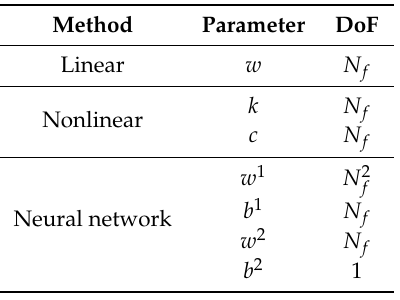
Table 1. Learnable parameters and their associated degrees of freedom (DoF) for the statistical models used in the present study. The degree of freedom is given for the prediction of a single arbitrary turbine within the wind farm with N f turbines in front. The linear and nonlinear learnable parameters apply to the deficit and standard